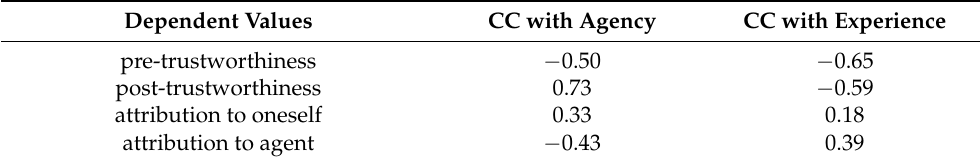
Table 6. Correlation coefficients (CC) between perceived agency and experience and each depen- dent value.